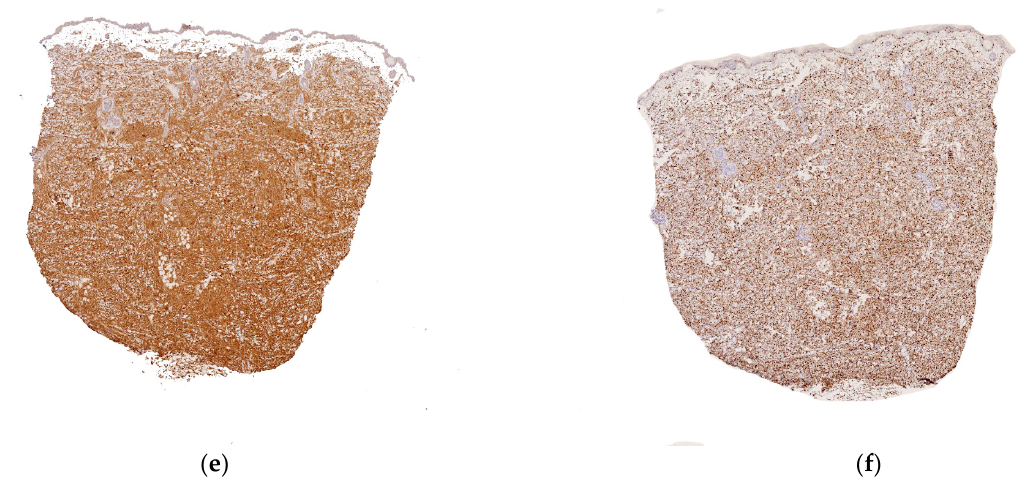
Figure 4. Congenital leukemia cutis: ( a ) blueberry muffin rash; ( b ) 4× dense dermal infiltration separated from the epidermis by a grenz-zone; ( c ) 10× medium-sized blastic cells arranged in single-file between collagen bundles and with a peri-vascular and peri-adnexal arrangement as well; ( d ) 25× apoptotic cells and mitotic figures; ( e ) CD68 intense positivity; ( f ) Ki67 immunostaining: almost 100% of nuclei are positive.